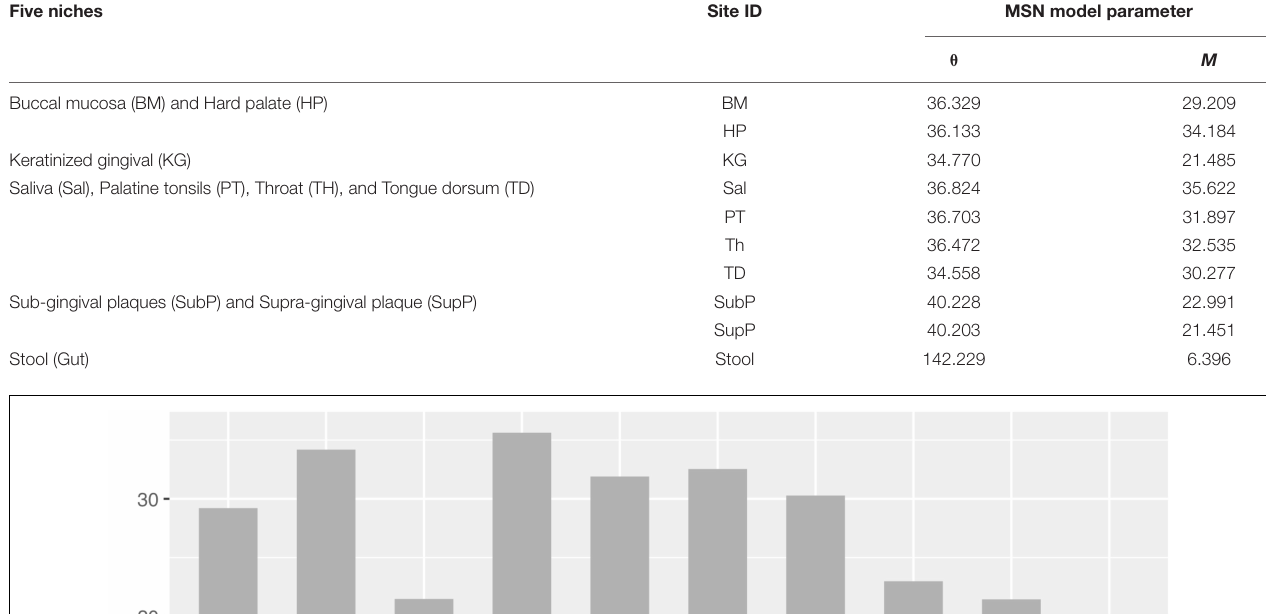
TABLE 3 | The mean MSN (multi-site neutral) model parameters of 10 DT (digestive tract) sites: the fundamental biodiversity number ( θ ) and fundamental dispersal number ( M ).